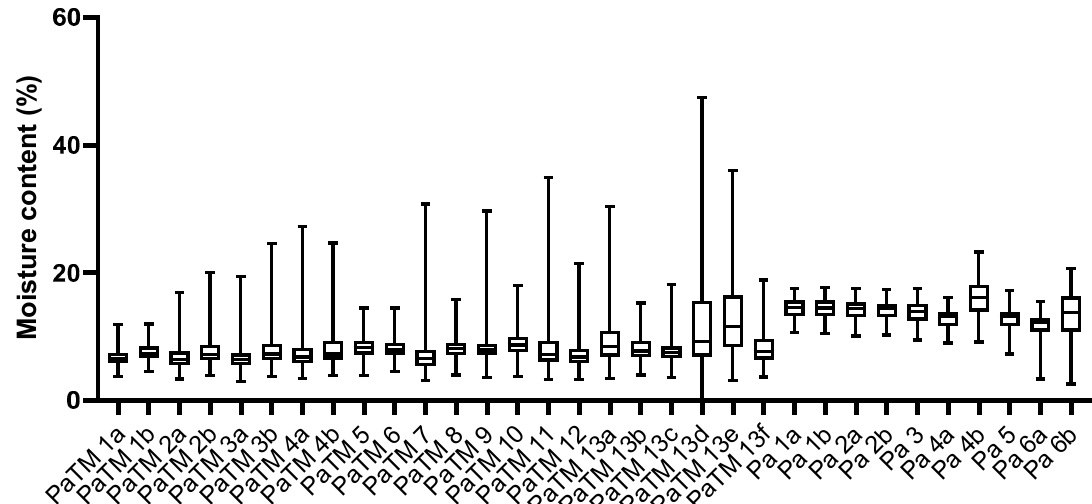
Figure 6. Wood moisture content at different monitoring positions on the façade of the Annex of the Wood Sci. and Tech. building. The box displays the mean values (25th and 75th percentile), while the whiskers stretch to the highest and lowest value. The abbreviations are the same as in Table 1.